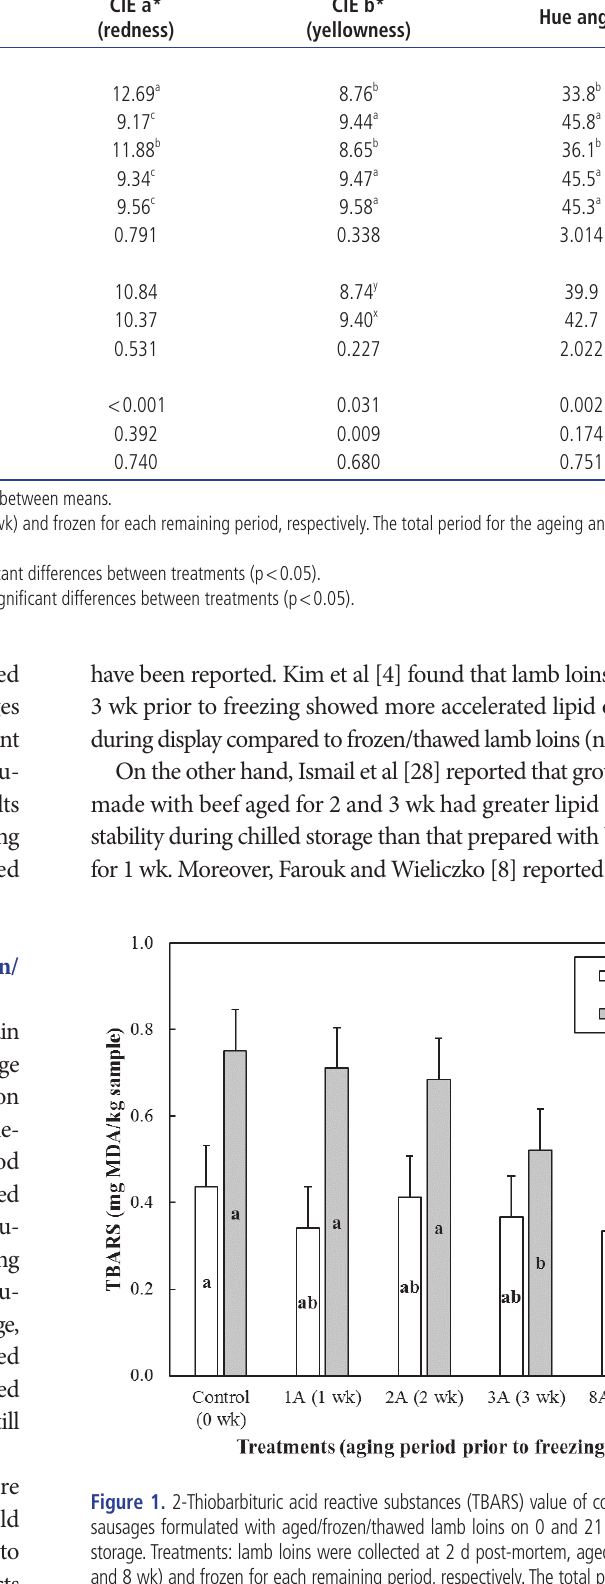
CIE L* (lightness)